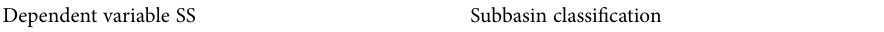
Table 6. Panel data regressions for suspended solids (SS) for all subbasins (Total), by type of agricul- ture (Olive, Coast, Semi-intensive and Mountain) and by existing time trend (Decreasing, Increasing, Minimum and No Trend). The regression models include significant variables (p<0.05)